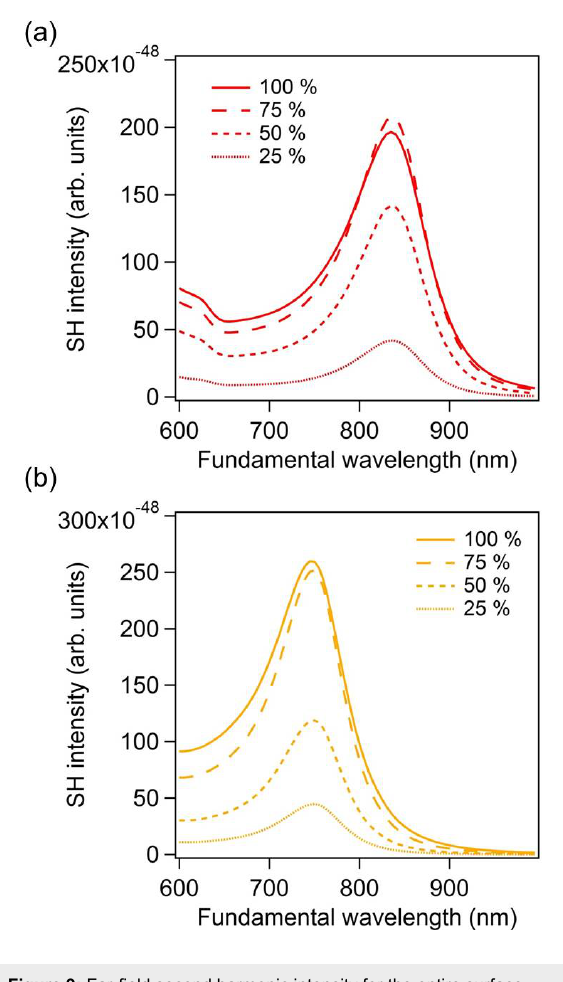
Figure 9: Far-field second harmonic intensity for the entire surface nonlinear polarization (100%) and for partial surface nonlinear polari- zations as indicated in the legends. The percentages indicate the ratio between the length over which the surface nonlinear polarization is maintained and the length of the nanorod, as in Figure 4 for the nanodimers with cylindrical sections. The gap between the nanorods is 5 nm for the panel (a) and 20 nm for panel